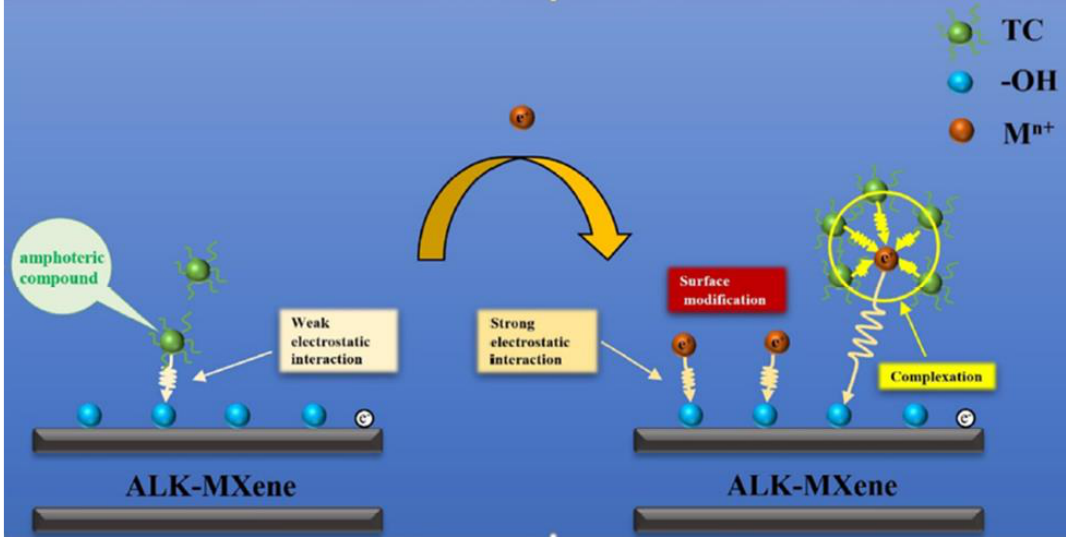
Figure 5. Adsorption mechanism of tetracycline using alkalized M-MXene adsorbent. (Reprinted with permission from Ref. [88]. 2022 American Chemical Society).